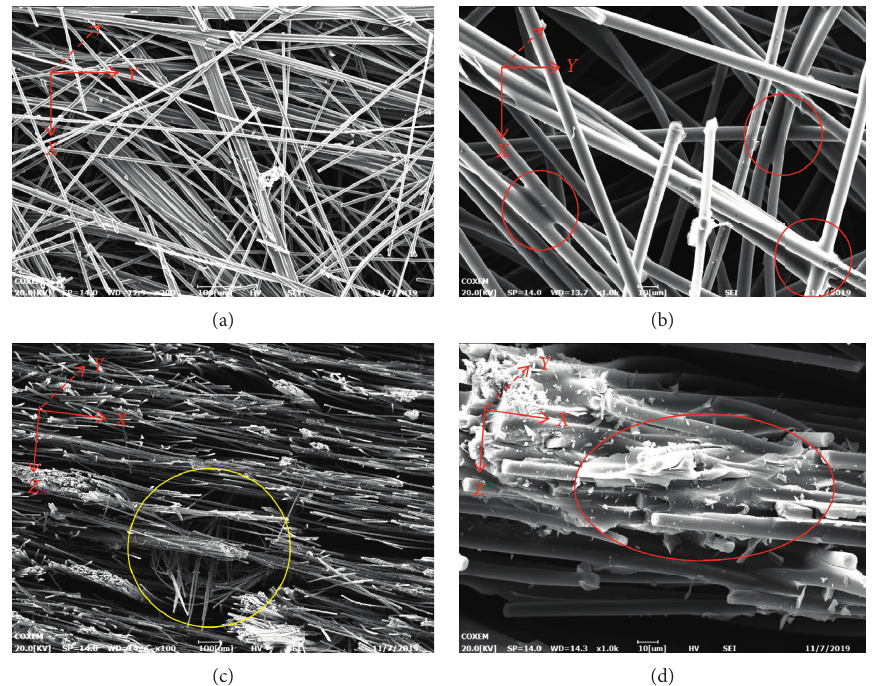
Figure 5: SEM images of carbon/carbon fiber composites: (a) and (b) inner surface (parallel to the laminate); (c) and (d) section (vertical to the